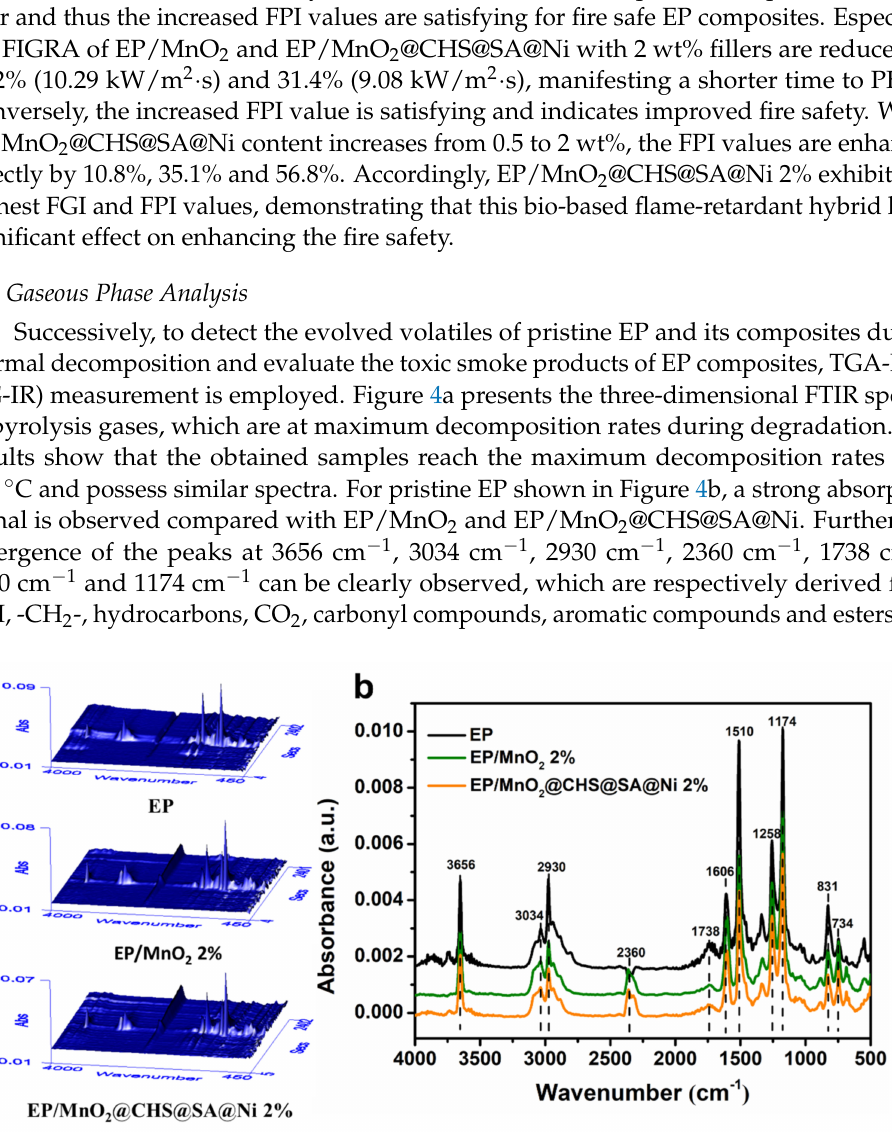
Figure 4. 3D FTIR spectra of pyrolysis products at maximum decomposition rates during the degradation process. ( a ) 3D FTIR spectra of control EP, EP/MnO 2 2%, and EP/MnO 2 @CHS@SA@Ni 2%. ( b ) FTIR spectra of pyrolysis products at maximum weight loss rate of pristine EP, EP/MnO 2